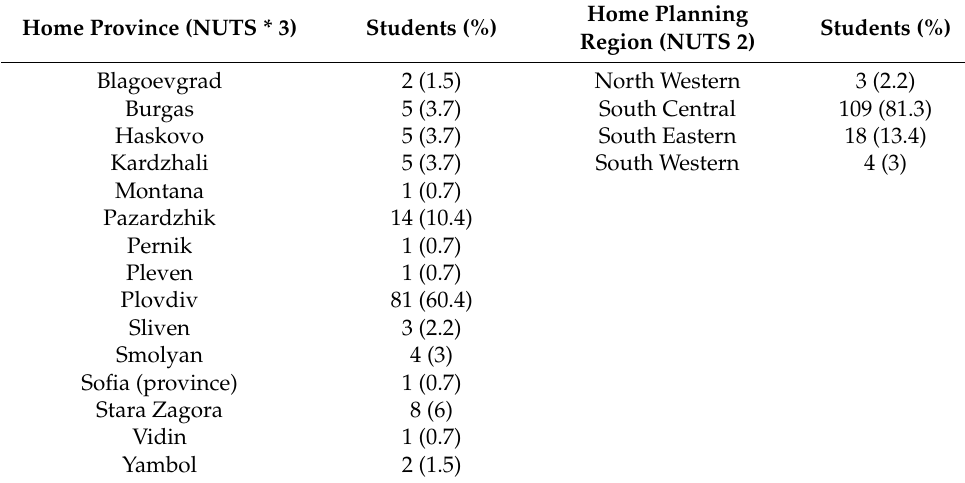
Table 3. Movement of students for their study.